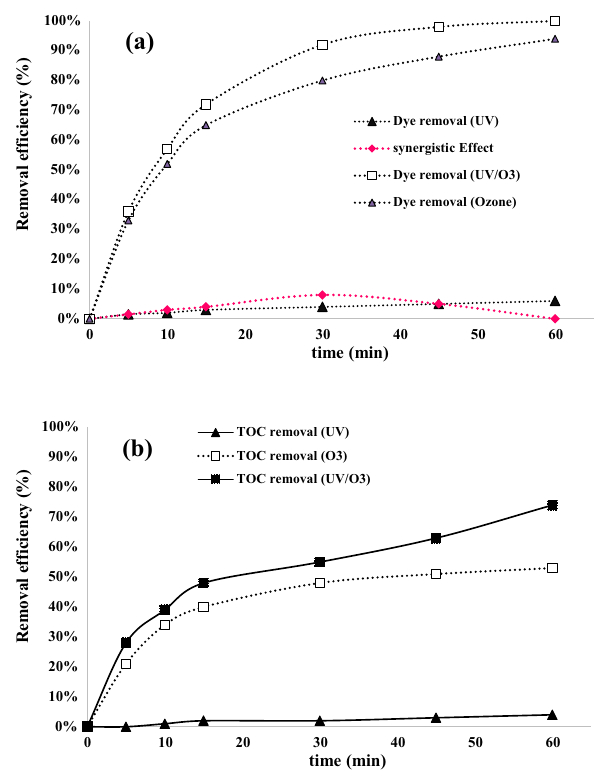
Fig. 4 Comparing the discoloration ( a ) and TOC ( b ) removal effi- ciency in photolysis (UV), ozonation (O 3 ) and hybrid O 3 /UV pro- cesses; ini pH = 8, [RR-198] = 50 mg/L, O 3 = 40